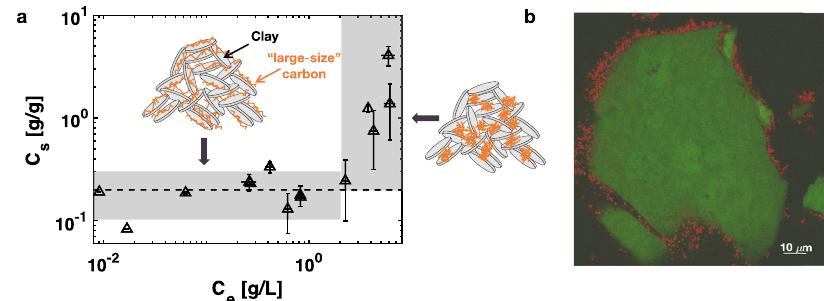
Fig. 2 Clay – carbon sorption isotherm and bacterial – clay interactions. a The sorption isotherm of 3 – 5 kDa dextran on clay suggests two sorption mechanisms. Each data point represents one batch sorption experiment, i.e., one experiment with 10 mg of clay added to 10 mL solution in a glass vial (see the “ Methods ” section). For each batch experiment, three drops were sampled from the solutions after the sorption and three sets of C e , organic matter concentration in solution, were estimated from the fl uorescence intensity measurements. Afterwards, three sets of C s , organic matter concentration sorbed to clay, were calculated from C e and the dextran concentration in solution before sorption (see the “ Methods ” section). The triangles and error bars represent the mean and the standard error of these three sets of measurements. b A typical confocal microscopy image of the distribution of red fl uorescent soil bacteria , Pseudomonas aeruginosa , around clay micro-aggregates loaded with green- fl uorescent